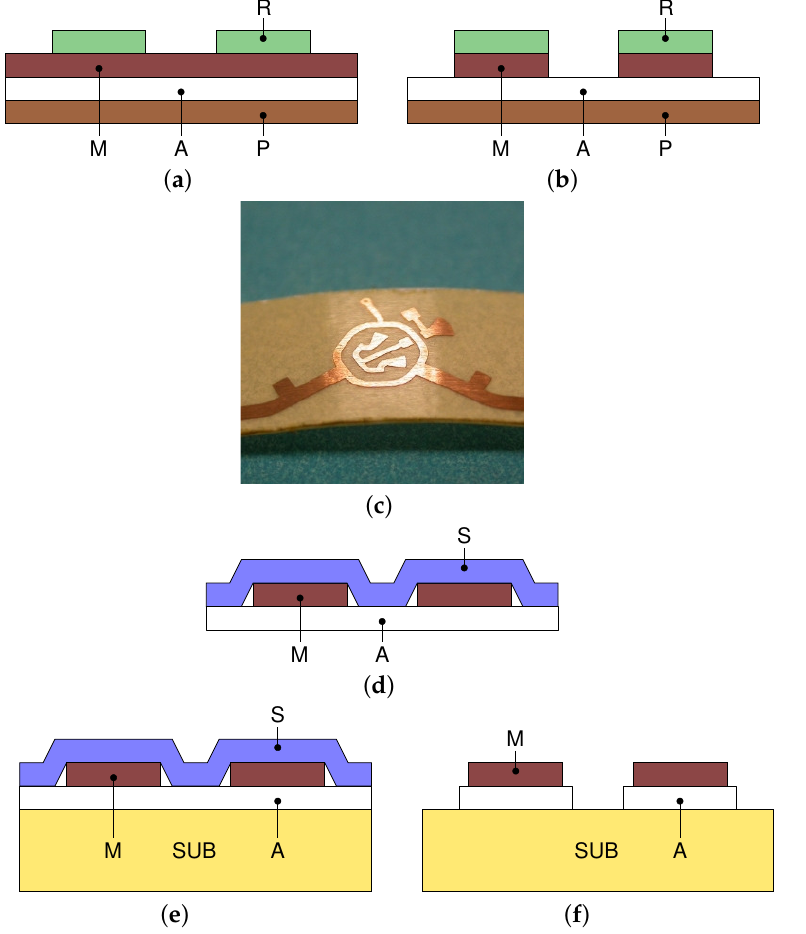
Figure 2. Fabrication process. ( a ) Photo-resist deposited on the metal layer and patterned using a mask, UV and a developer. ( b ) Wet etching of the metal surface. ( c ) Adhesive laminate after the etching of the metal layer: the adhesive material underneath is exposed. ( d ) Application of the sacrificial layer and removal of the protection layer. ( e ) Circuit transferred to the host substrate. ( f ) Sacrificial layer removal; the last step also removes the adhesive material. M: metal, A: adhesive, P: protection, R: photo-resist, S: sacrificial layer, SUB: host